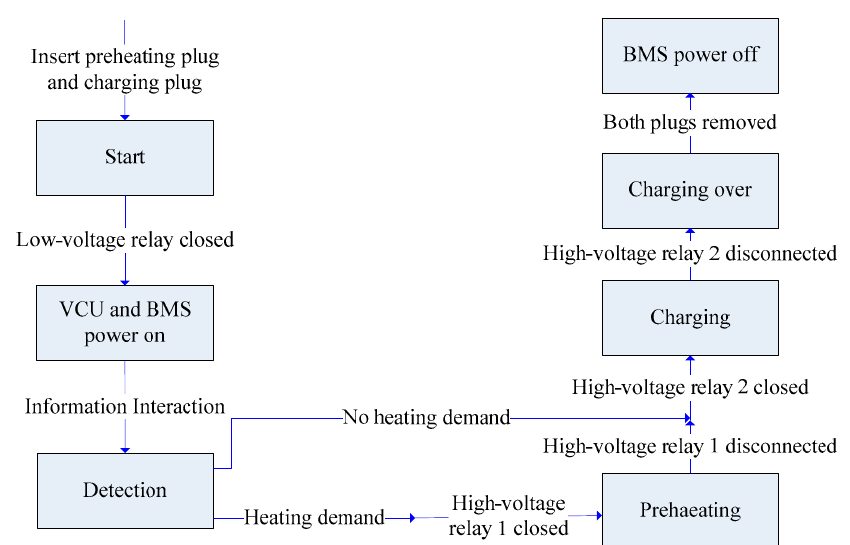
Figure 16. The control strategy for coordinating the processes of preheating and charging.